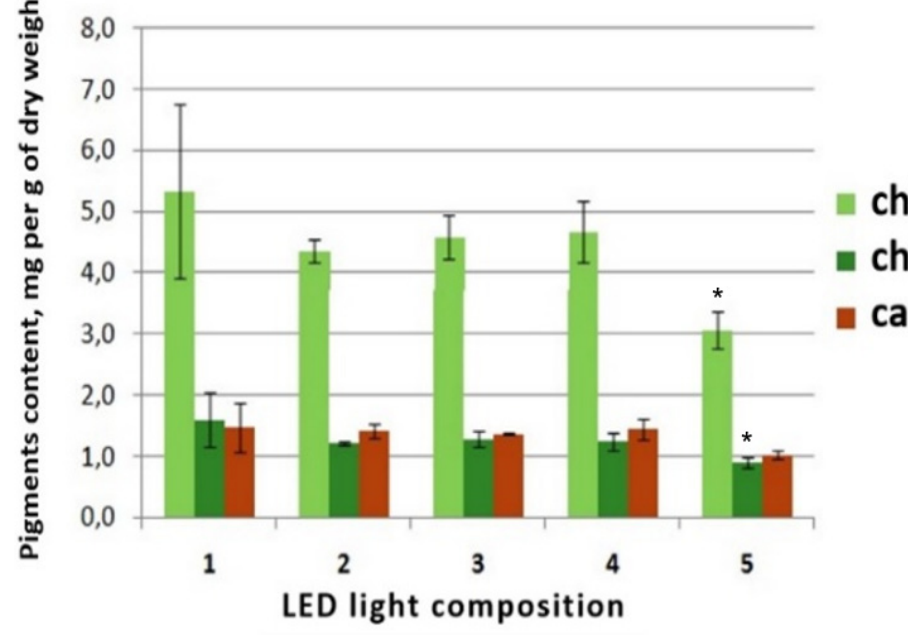
Figure 9. The effect of spectra composition on concentrations of chlorophylls a , b and carotenoids in S. rebaudiana plants grown in vivo under various red-blue LED lightings: (1) SR + LR + FR + B; (2) LR + FR + B; (3) SR + FR + B; (4) SR + LR + B; and (5) SR + LR + FR (Figure 2). Means ± standard errors at α = 0.05 according to ANOVA tests (n = 10). *-variants that have significant differences between control treatments (SR + LR + FR + B).